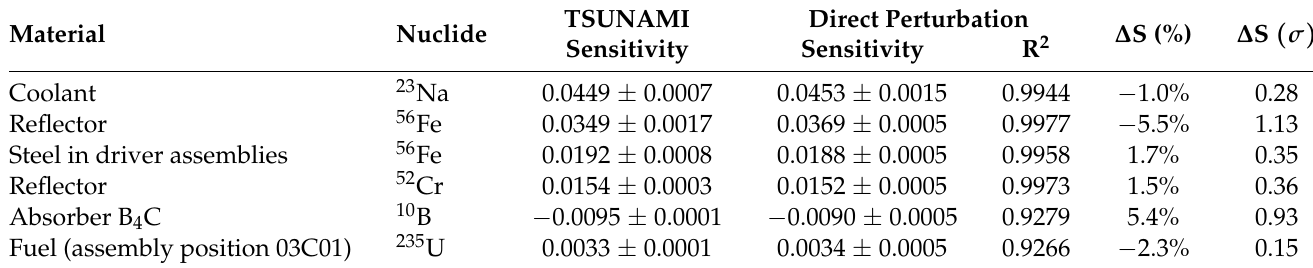
Table 4. k eff sensitivities obtained using direct perturbation compared to corresponding TSUNAMI results using ENDF/B-VII.1 data.